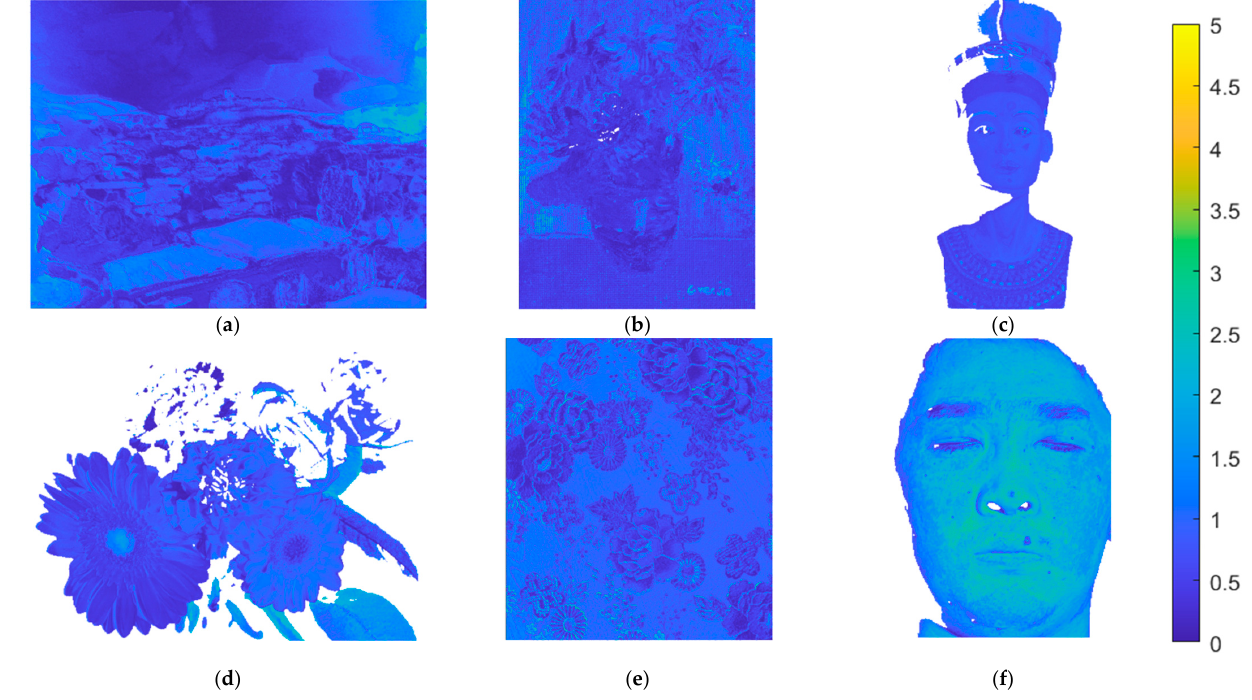
Figure 18. ( a – f ) showing the Δ E 00 maps for the test images in Figure 15a–f, respectively, using the II-LUT method and RGBF camera. Pixel Δ E 00 values greater than 5.0 are set to 5.0.